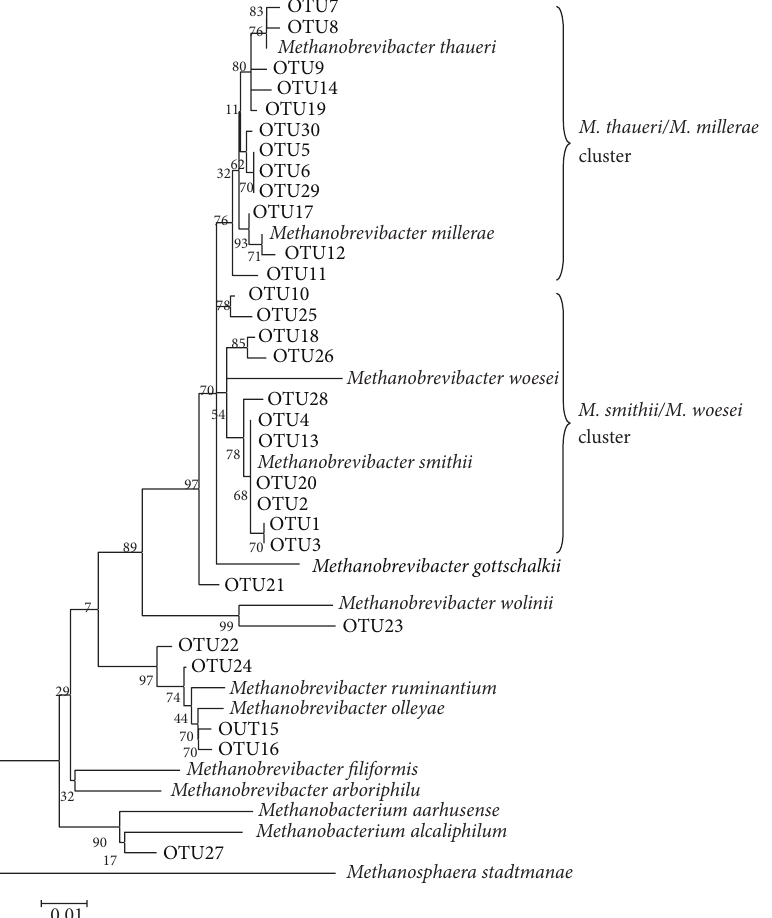
Figure 4: Unrooted phylogenetic tree of Methanobrevibacter spp. reference strains and predominant OTUs in the libraries from faecal methanogens of Meishan and Yorkshire piglets. The reference bar indicates 1% sequence